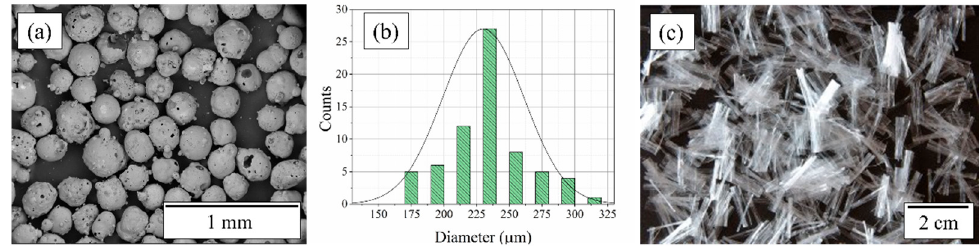
Figure 1. SEM image of cenospheres ( a ), histogram of cenosphere particles size distribution ( b ) and LM image of the polypropylene Belmix™ fibers ( c ).